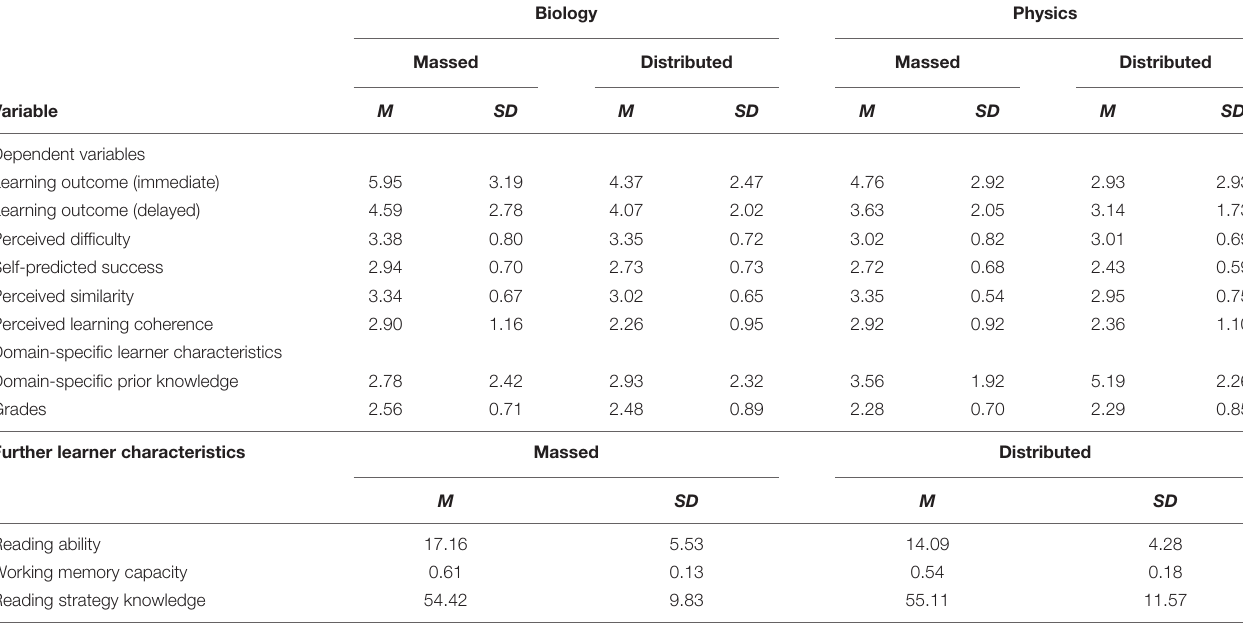
TABLE 1 | Means and standard deviations of dependent variables and learner characteristics in Experiment 1.